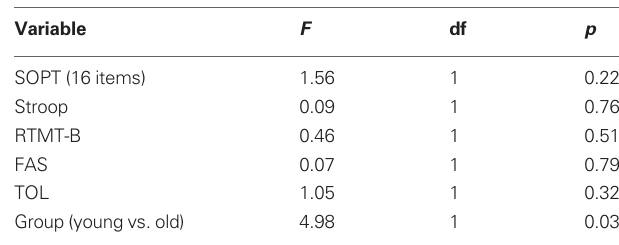
Table 6 | Results of an analysis of covariance with parameter estimates in dlPFC (“learned” vs. “search” ) as dependent variable, scores of other tests assessing executive functions (SOPT, Stroop, RTMT-B, FAS and TOL) as covariates, and a two-level independent group variable (young vs. old) .